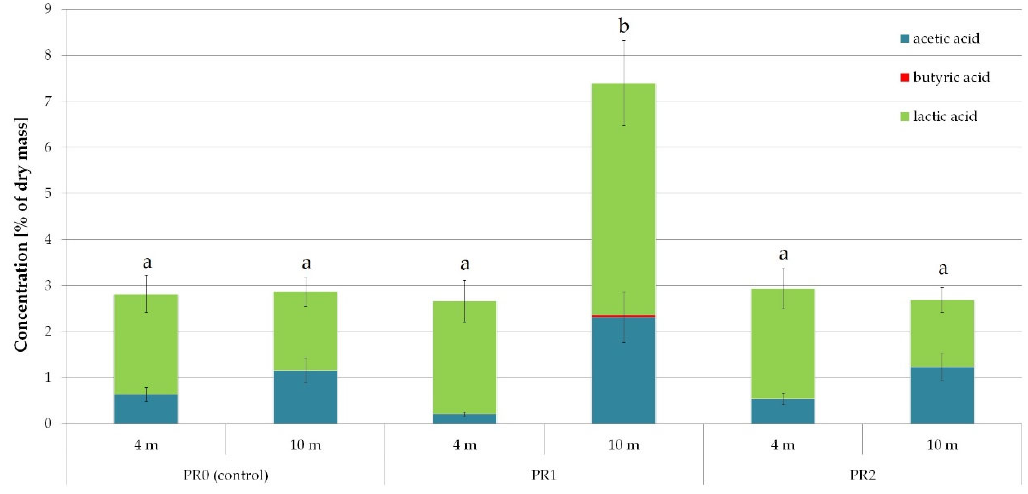
Figure 11. Content of organic acids in tested silages after 4 and 10 months of storage. Bars marked with the same letters indicate no statistical difference ( p < 0.05); statistical significance analysis was performed for the sum of organic acids.